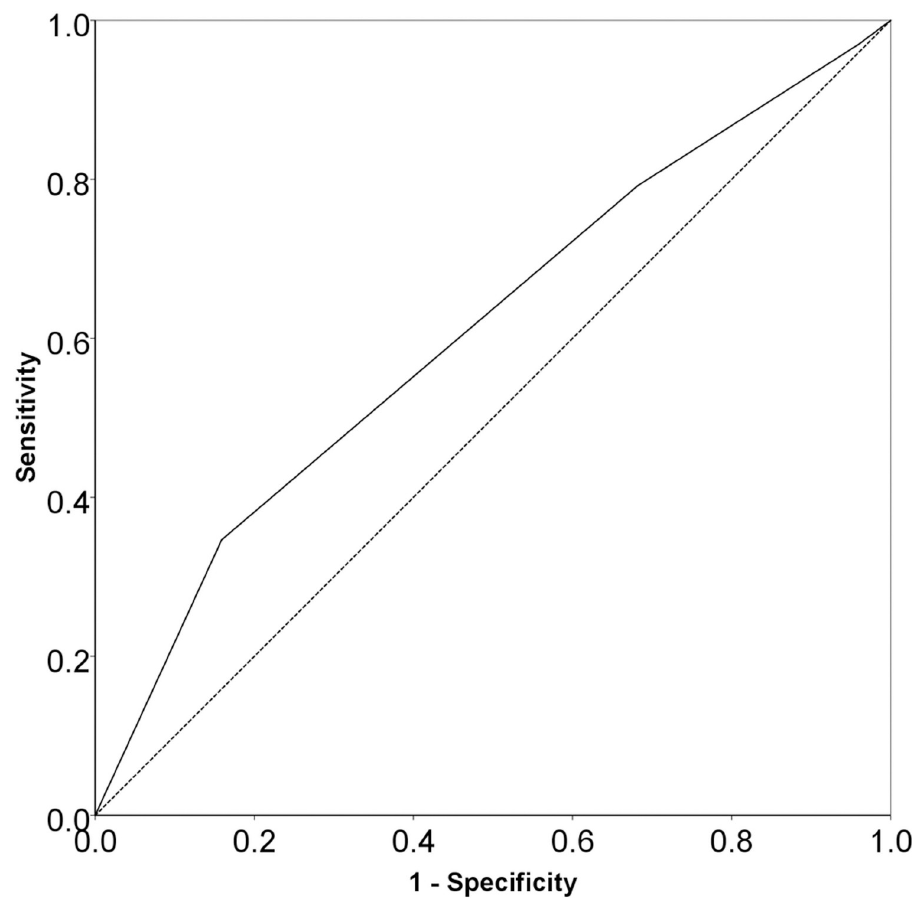
Fig 1. The area under the ROC curves of the qSOFA score (AUROC: 0.610 [95% CI: 0.538–0.681]; cut-off value: � 2.5; sensitivity: 34.7%; specificity: 84.1%; P AUROC = 0.003) for predicting the hospital mortality in ICU patients with sepsis in Vietnamese ICUs. Abbreviations: AUROC , area under the receiver operating characteristic curve; CI , confidence interval; ICU , intensive care unit; qSOFA , Quick Sequential Organ Failure Assessment; ROC , receiver operating characteristic; SOFA , Quick Sequential Organ Failure Assessment.